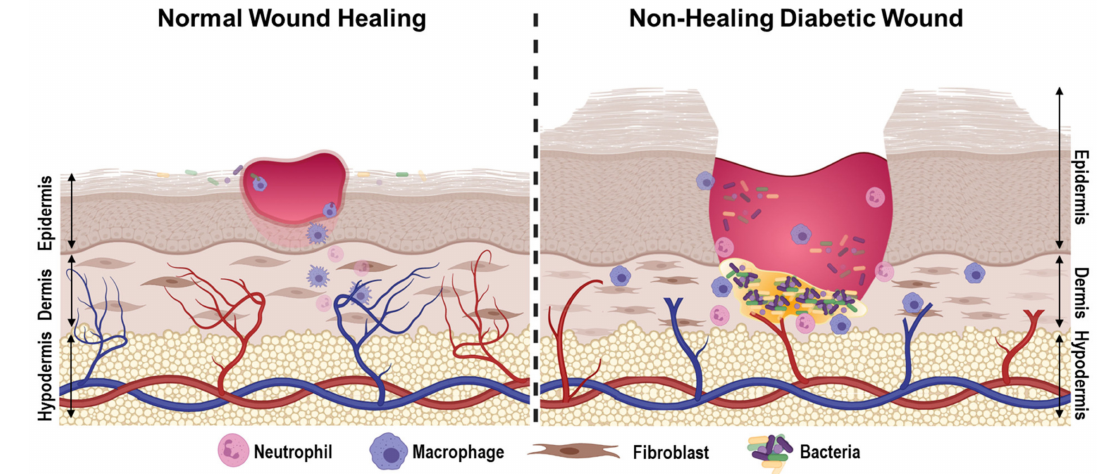
Figure 1. Pathophysiology of diabetic wounds. Diabetic wounds exhibit deregulated angiogenesis, chronically sustained sub-optimal inflammatory response, increased levels of reactive oxygen species, and persistent bacterial colonization that often develops into a hard-to-treat biofilm. Created with BioRender.com, 29 July